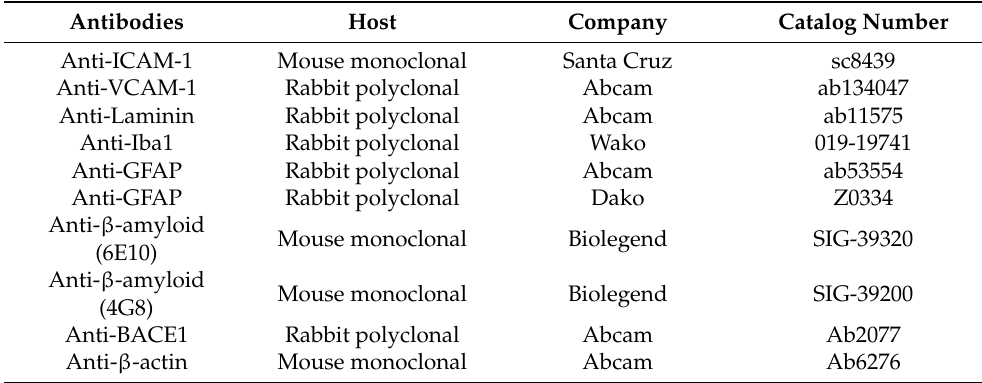
Table 1. List of antibodies for Western blot analysis and immunofluorescence